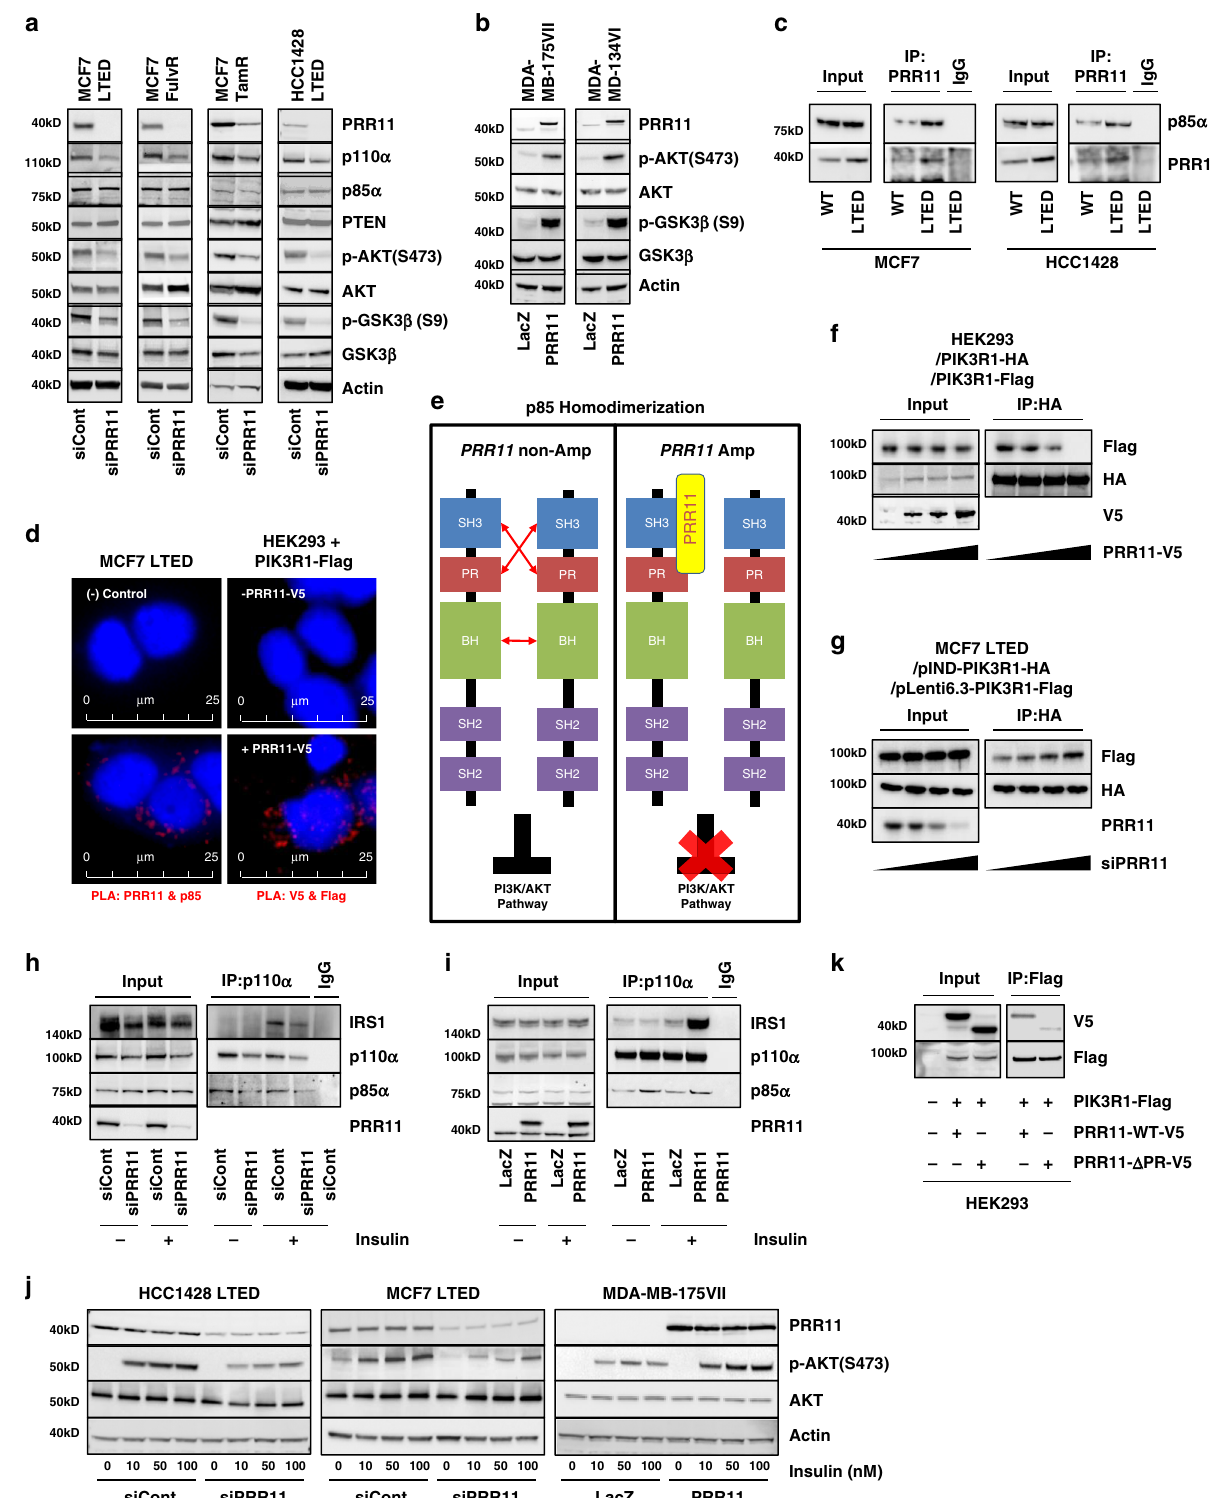
PI3K inhibitors pictilisib and taselisib (Fig. 7b). Furthermore, breast cancer cell lines with PRR11 ampli fi cation displayed sig- ni fi cantly higher sensitivity to the PI3K inhibitor pictilisib com- pared to cell lines without PRR11 ampli fi cation in the LINCS MGH/Sanger dataset of Drug/Cell-line Browser (DCB 42 ; Fig. 7c). It was previously shown that ectopic expression of mutant PIK3CA sensitizes these cells to PI3K inhibitors 43 . Likewise,